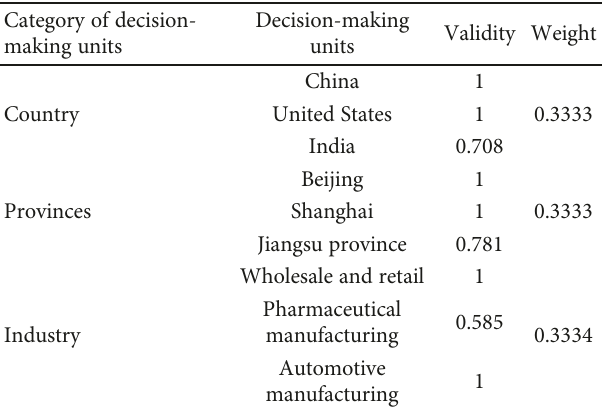
Table 11: Validity coe ffi cients of DEA and associated weights.